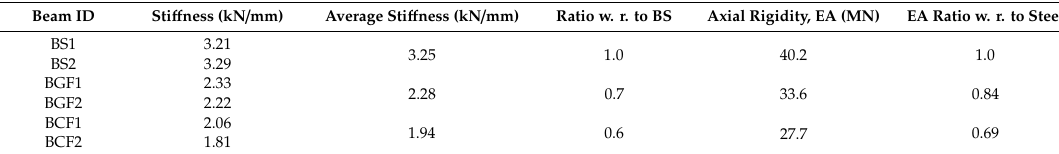
Table 5. Sti ff ness of tested beams.